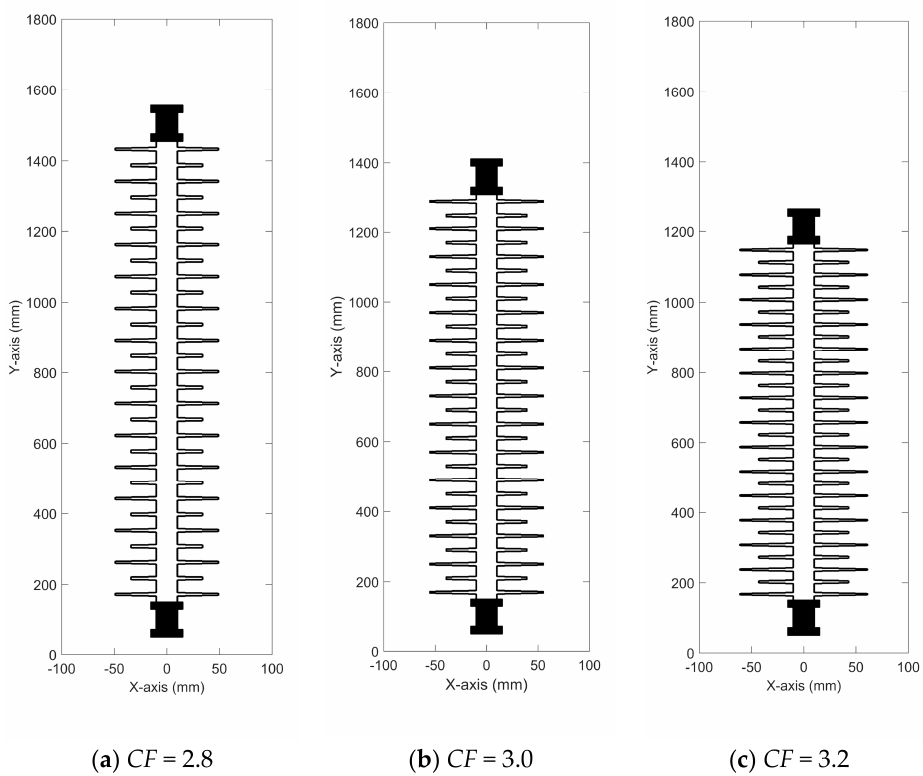
Figure 13. Insulator geometry with different CF values ( θ = 10° and k shed = 0.8).